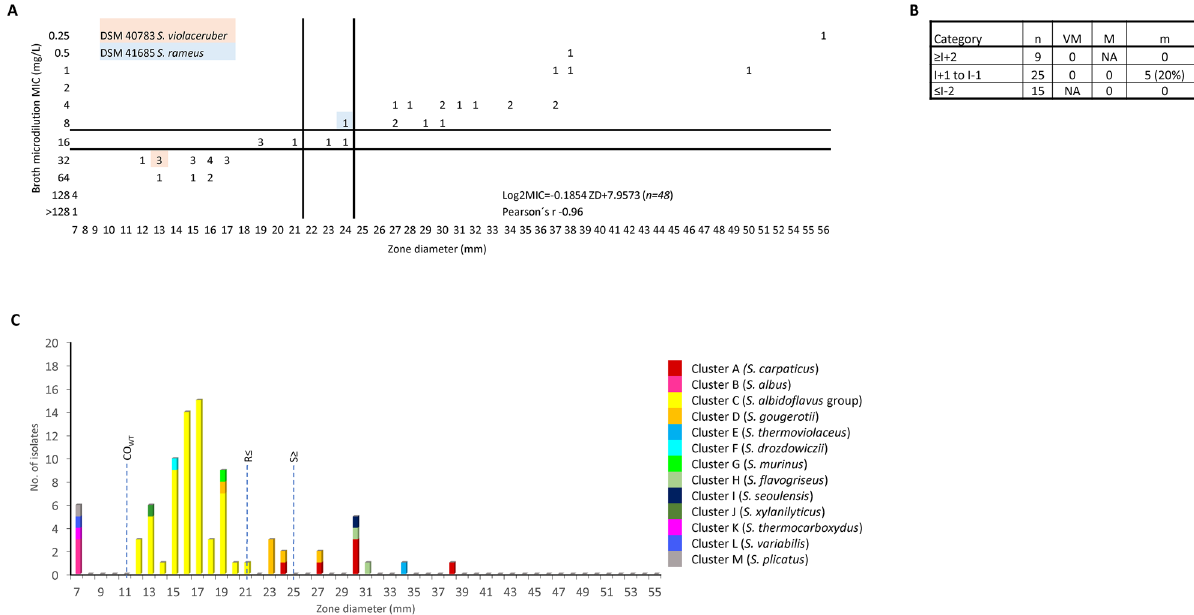
Figure 2. Ampicillin. Results of the correlation analysis of BM and DD methods followed by susceptibility testing of clinical isolates. ( A ) Scattergram comparing the results of broth microdilution MICs (mg/L) and zone diameters (mm) for 49 Streptomyces strains. The lines represent the proposed ZD interpretive criteria. ( B ) The table displays the number of tested isolates (n), very major error (VM), major error (M) and minor error (m). ( C ) The graph depicts the zone diameters distribution for 84 clinical Streptomyces strains. Dotted lines represent proposed zone diameter breakpoints (R—resistant category, S—susceptible category) and the CO WT value. Individual phylogenetic clusters are distinguished by colour. Based on the scattergram data, distribution of MICs and zone diameters, breakpoints were set as R ≤ 18 mm, I = 19–24 mm and S ≥ 25 mm, with no very major or major error and 4% of minor error (1 strain). However, when evaluating the zone size distribution of clinical strains, the CO WT of dominant cluster C was calculated to be 11 mm, indicating that the entire cluster C is resistant to ampicillin. Therefore, to minimise the risk of setting clinical breakpoints which split the resistant population (dominant cluster C) and in order to prevent misclassification of resistant strains as intermediate (I), we propose to use interpretive breakpoints as R ≤ 21 mm, I = 22–24 mm, and S ≥ 25